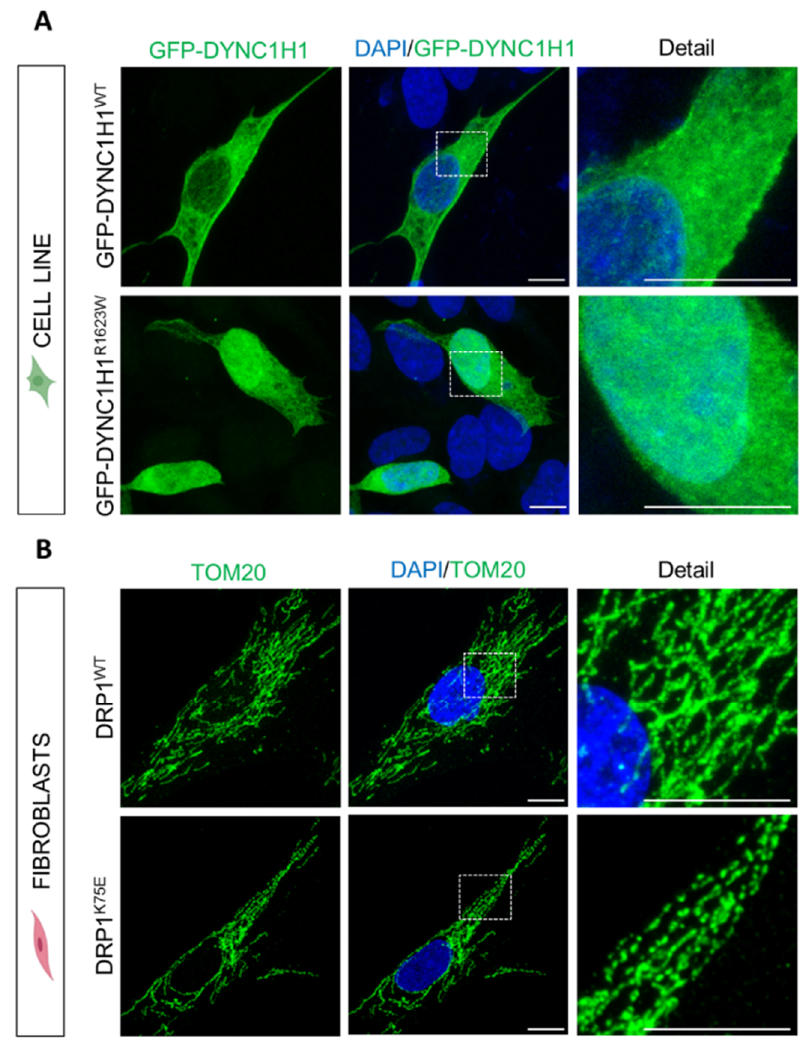
Figure 2. Experimental functional studies in patients with genetic variants in DYNC1H1 and DNM1L (encodes DRP1) using a cell line model and patient’s fibroblasts. ( A ) Cellular expression pattern of GFP- DYNC1H1 WT (top panels, green, wild-type) and GFP- DYNC1H 1 R1623W (bottom panels, green, patient’s variant) in SH-SY5Y-transfected cells. GFP- DYNC1H1 WT was observed in the cytoplasm, whereas GFP- DYNC1H1 R1623W was abnormally delocalized at the nuclei. ( B ) Mitochondrial network structure stained with TOM20 (green) and nucleus (DAPI; blue) in fibroblasts of control (top panels, DRP1 WT ) and patient (bottom panels, DRP1 K75E ). Patient’s fibroblasts showed an abnormal mitochondrial network chain-like structure. The magnification of the withe dashed boxes regions are shown in the right panels (detail). Scale bar: 10 µm.